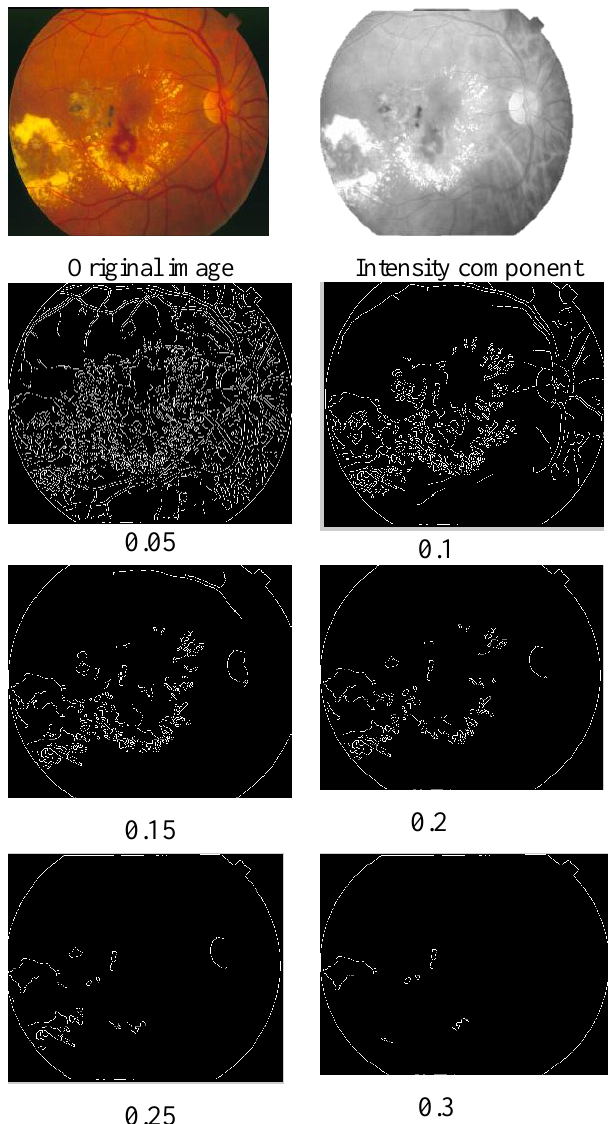
Fig.7: Canny edge detector to obtain the edges of the retina image using 6 different thresholds: 0.05, 0.1, 0.15, 0.2, 0.25, and 0.3